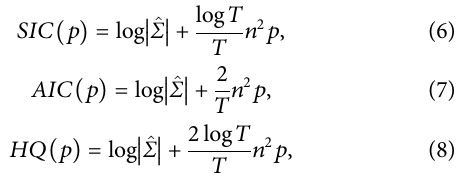
error correction model based on the cointegration relationship